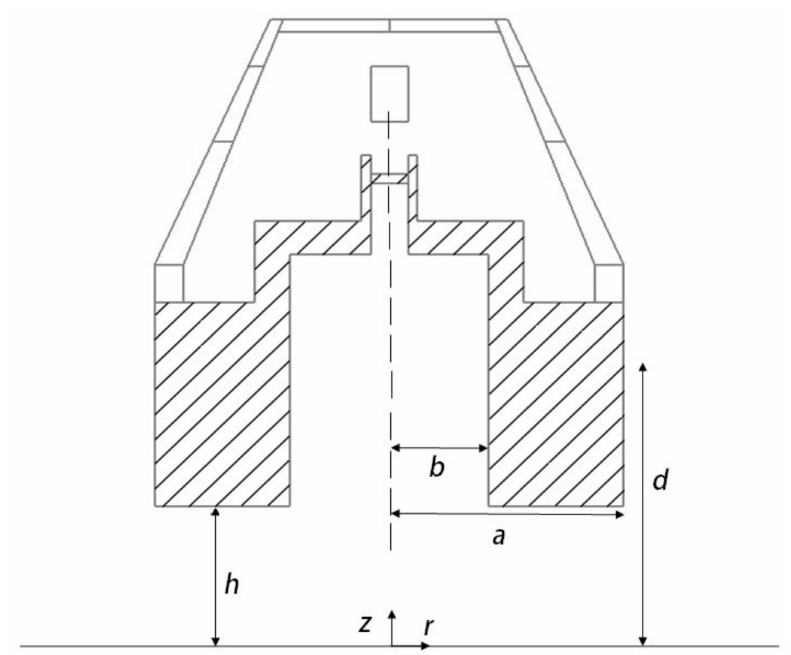
Figure 7. A restrained vertical symmetric OWC with finite wall thickness [26].